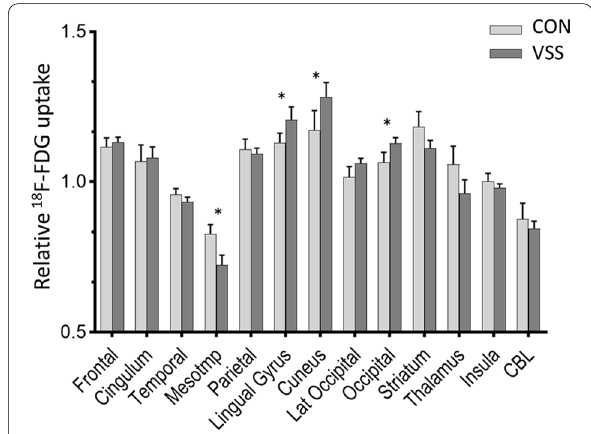
At voxel level p height-cluster FWE-corr < 0.05 (A.1) and p height-cluster uncorr < 0.001 (A.2 and B) with cluster extent 200 voxels